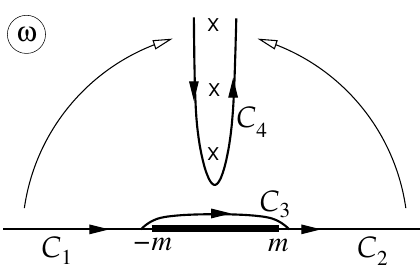
Figure 17. Contours in the ω -plane used in the calculation of the thermal, Hartle-Hawking and Unruh Green’s